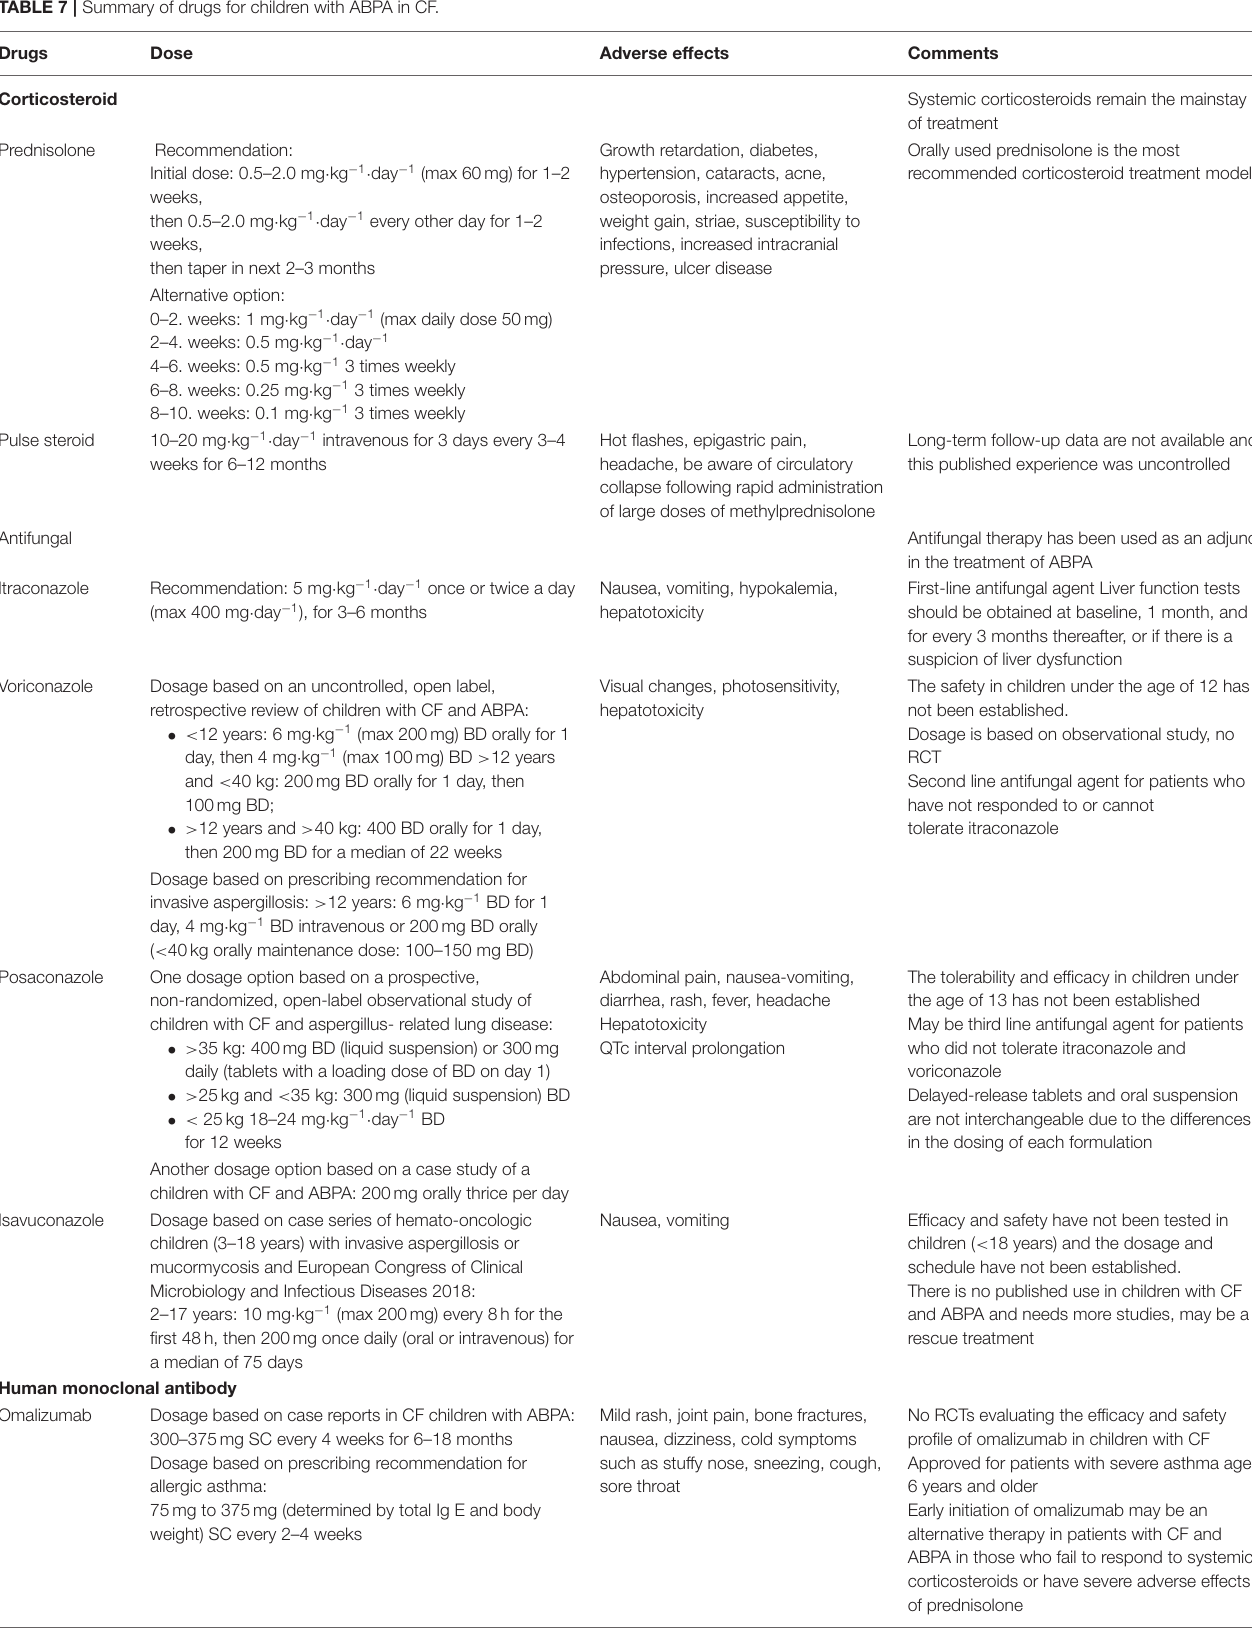
TABLE 7 | Summary of drugs for children with ABPA in CF. Drugs Dose Adverse effects Corticosteroid